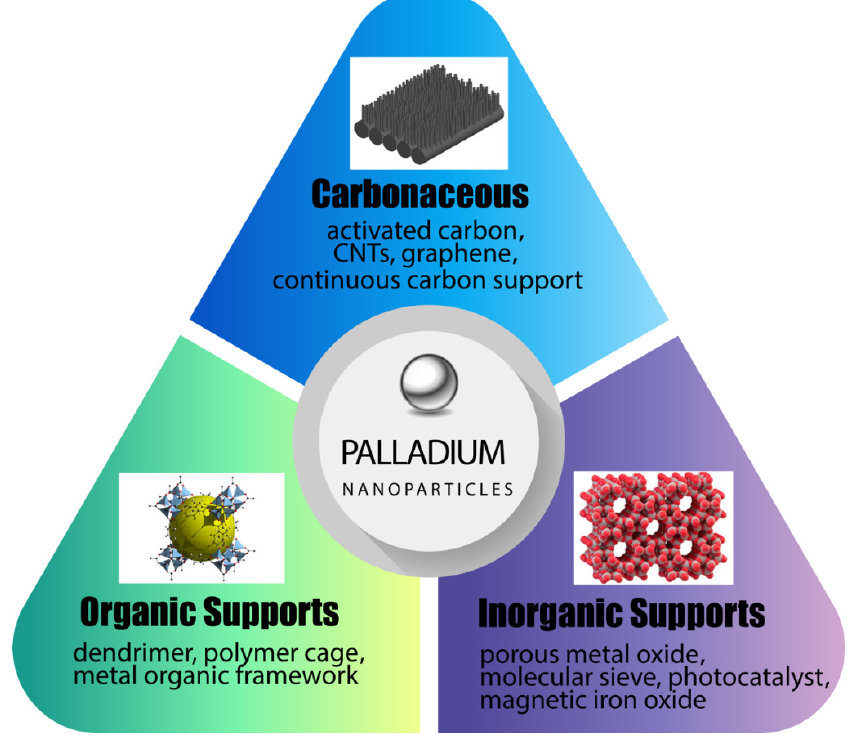
Figure 1. Schematic illustration of different types of support for palladium nano-catalyst.